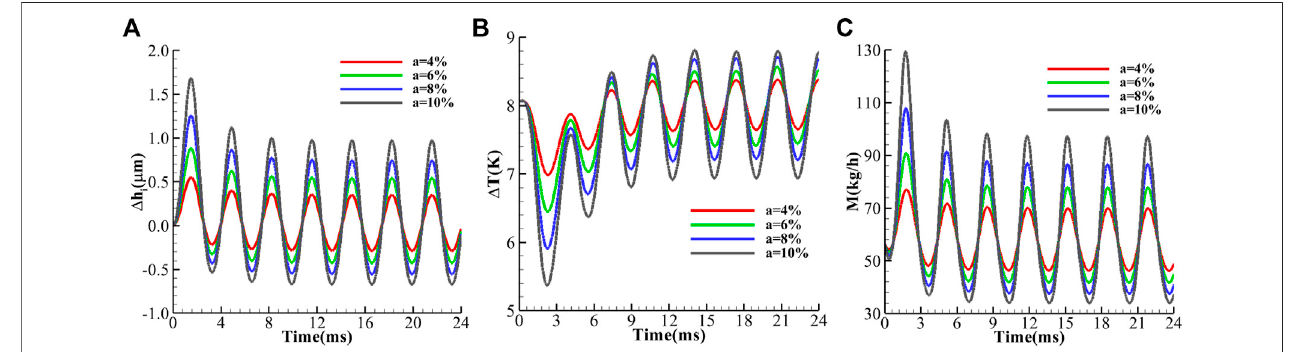
FIGURE 11 | Variation of parameters with time (A) static ring displacement, (B) inlet-to-outlet temperature difference, and (C) the leakage.